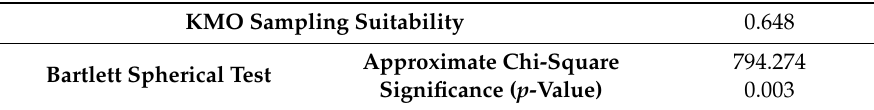
Table 2. KMO and Bartlett test.